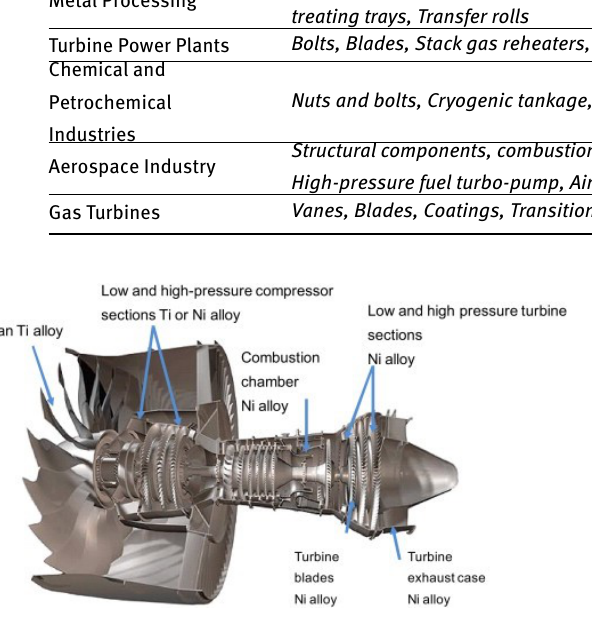
Figure 1: Nickel based superalloy positions in a jet engine [5]